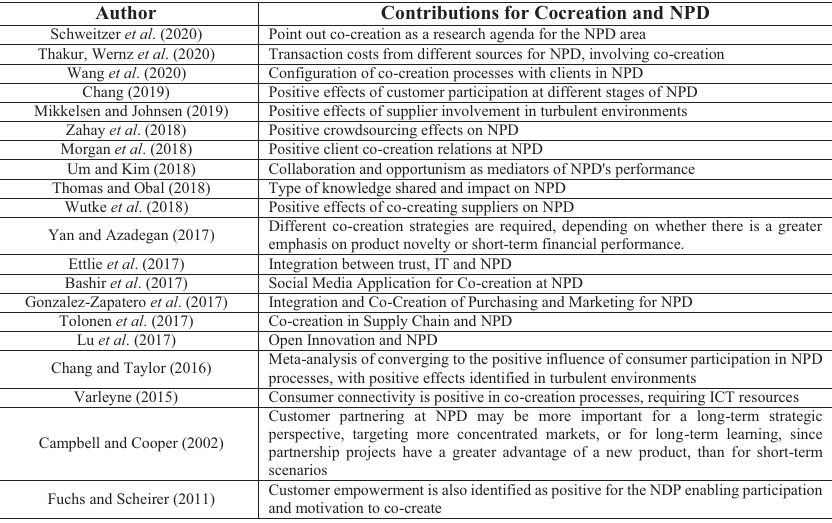
Figure 6. Co-creation and